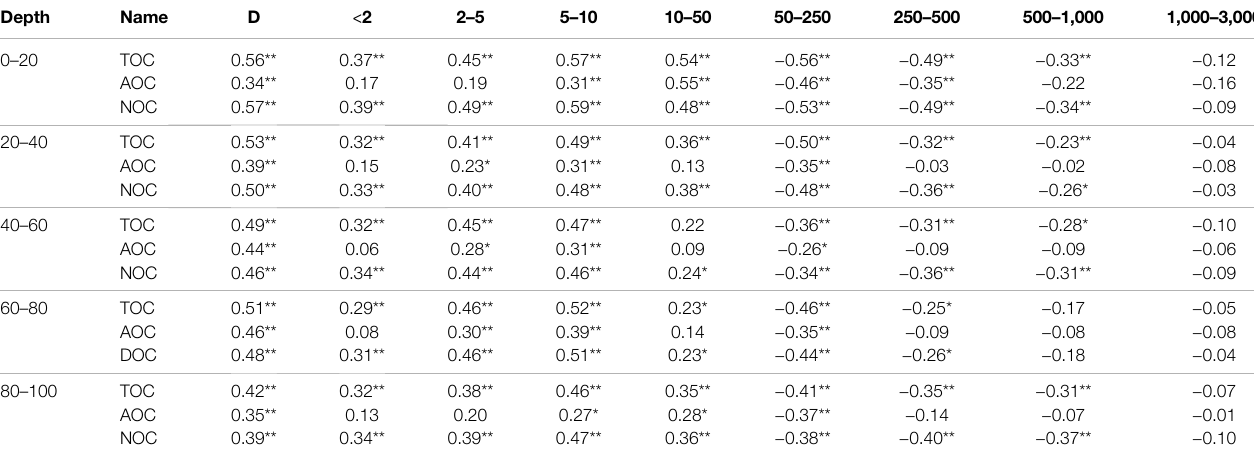
TABLE 5 | Correlation analysis between the soil particles and SOC in the farmland in the fl ooded area. Depth